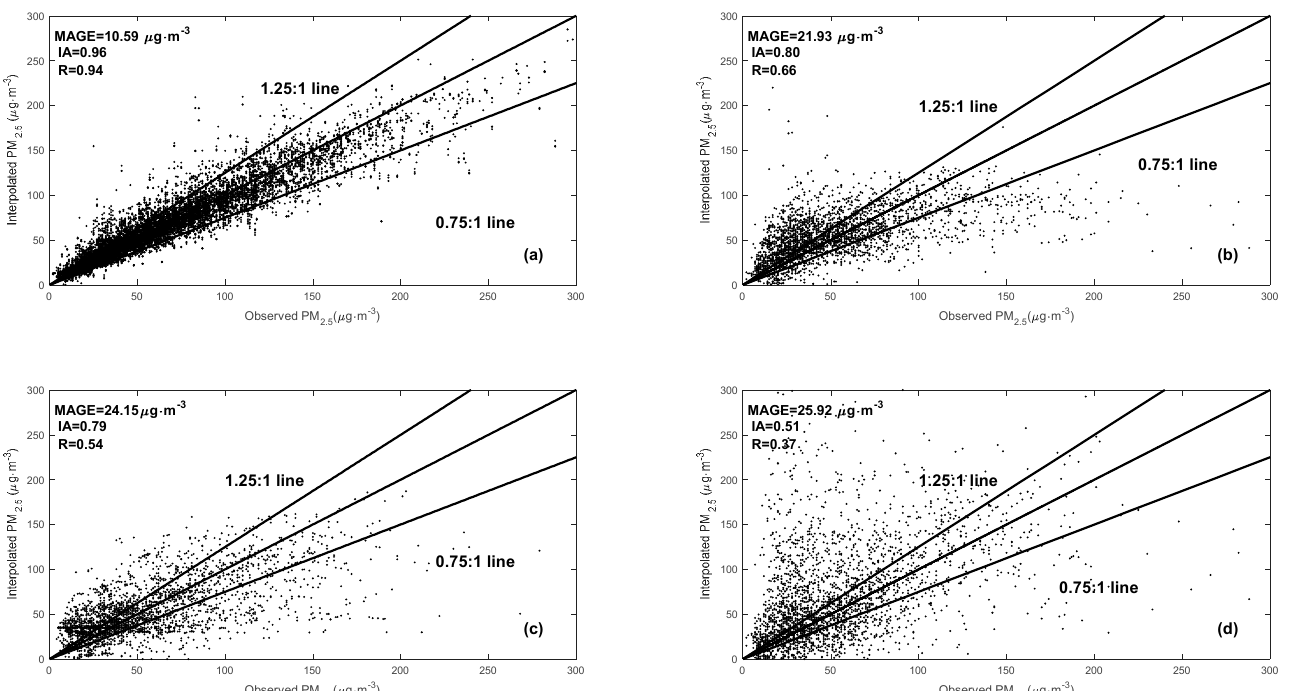
Figure 3. Scatter plots and performance of different methods for the 8-fold cross-validation experiments on 8–11 November 2014: ( a ) Performance of the 8-fold cross-validation DCIM simulations in the interpolated samples, ( b ) Performance of the 8-fold cross-validation DCIM simulations in the checked samples, ( c ) Performance of the 8-fold cross-validation kriging simulations in the checked samples, ( d ) Performance of the 8-fold cross-validation COPF simulations in the checked